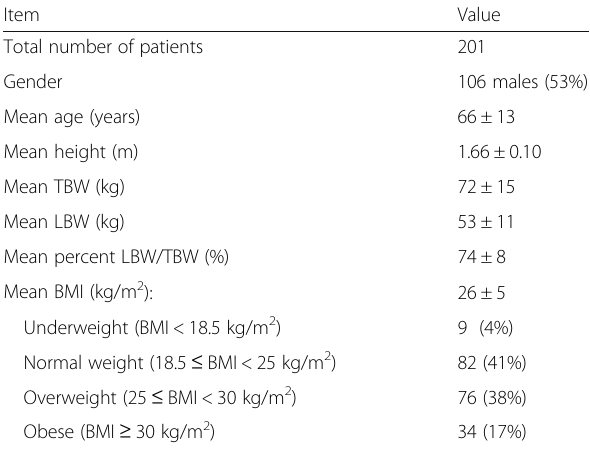
Table 1 Demographic characteristics of 201 patients of the study population